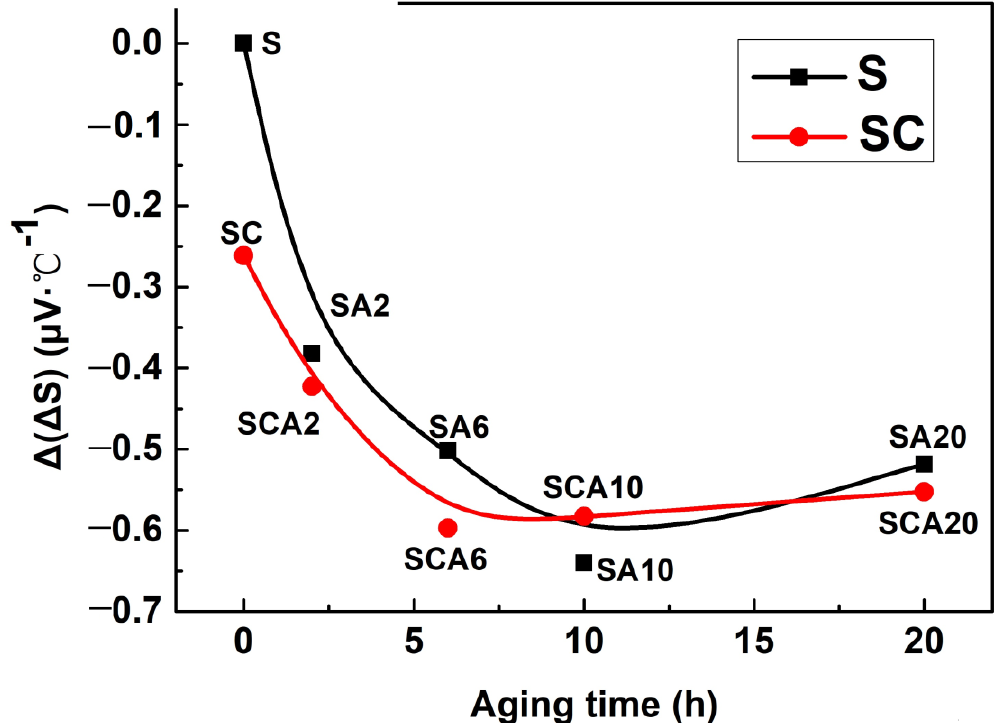
Figure 10. The TEP values of the S and SC samples change with the aging